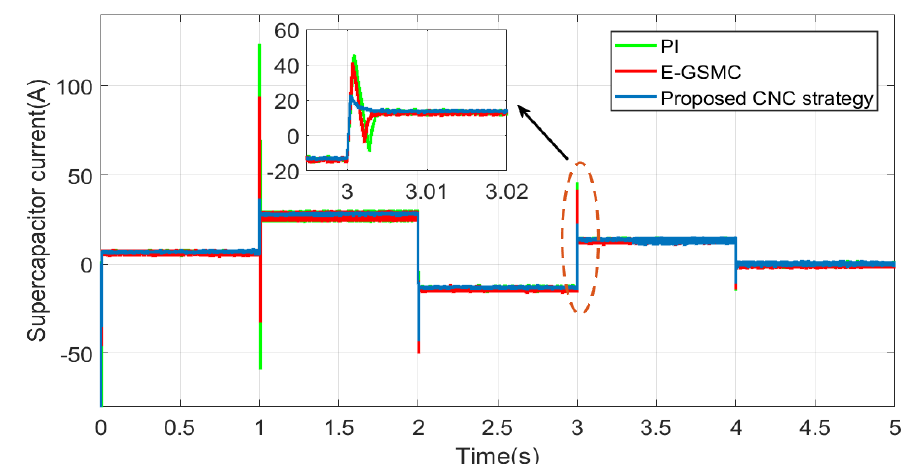
Figure 8. The robust tracking curve of the supercapacitor current.